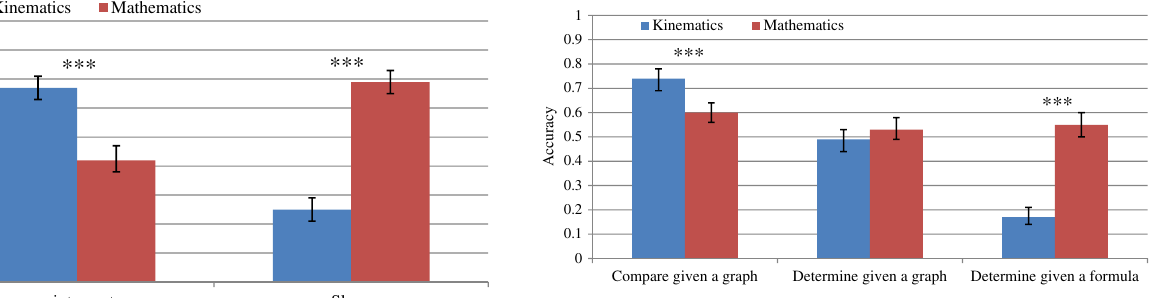
FIG. 3. GEE results for the term context * concept . The p value of the comparisons is indicated by * for p < 0 . 05 , ** for p < 0 . 01 , *** for p < 0 . 001 . Highly significant differences are found between the contexts for each of the concepts.